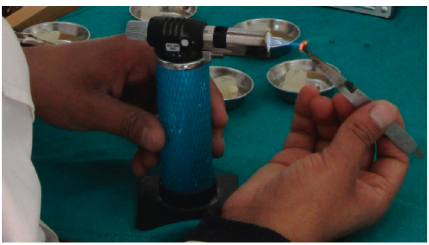
Figure 1: Flaming of